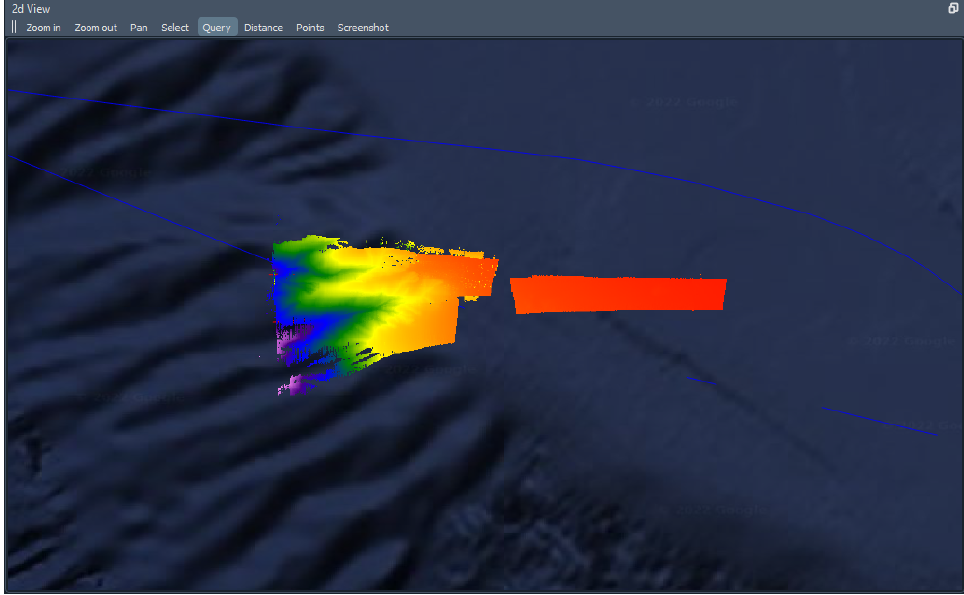
Figure 6. Patch Test Area with an 8.0 m resolution gridded dataset of the processed multibeam